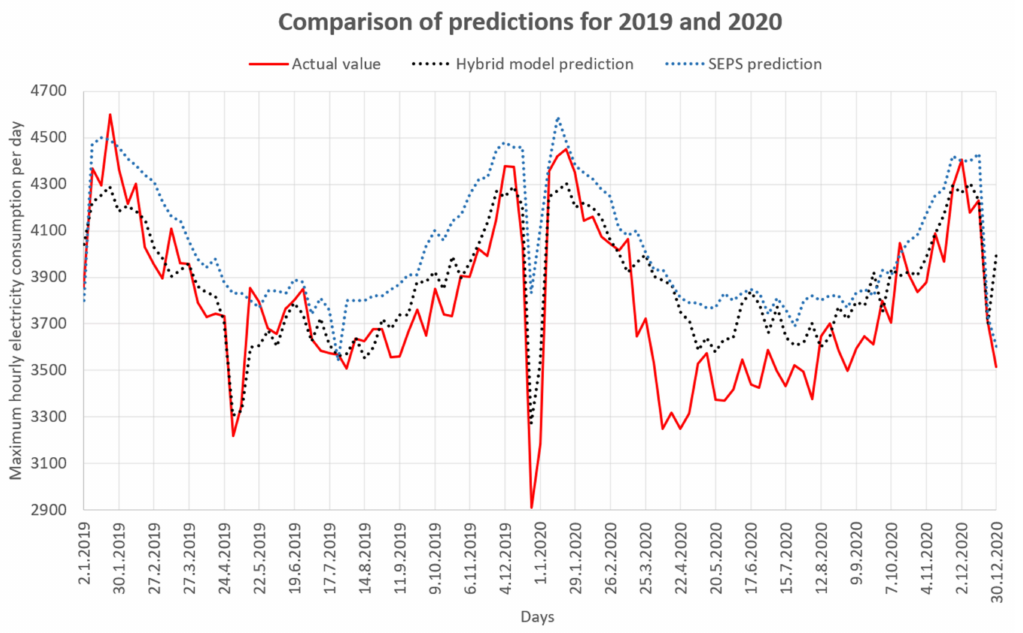
Figure 12. Comparison of predictions for the years 2019 and